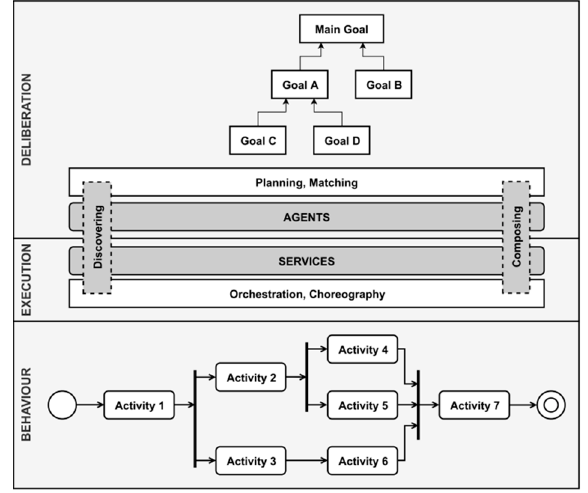
Figure 13. Architectural concepts of the ICA.